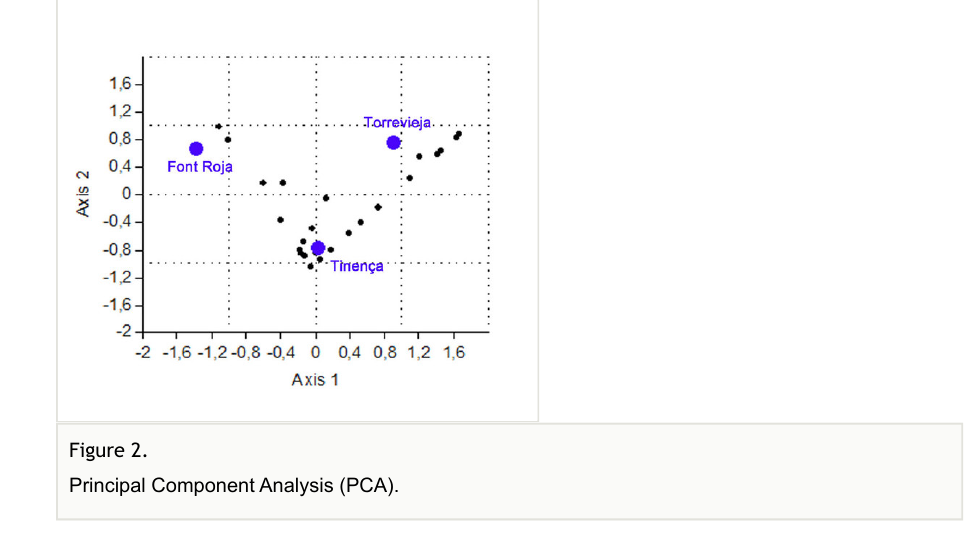
The indices of species replacement by the Whittaker index (Table 3) show that the Natural Park of La Tinença de Benifassà has not a lot of replacement with species from other Natural Parks, while, Torrevieja and Font Roja show some replacement. This relationship could be possible thanks that these natural parks are close while Tinença is far.